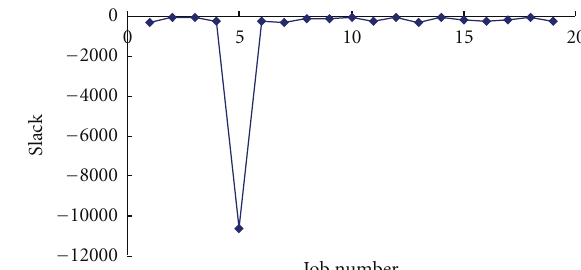
Figure 1: The extreme